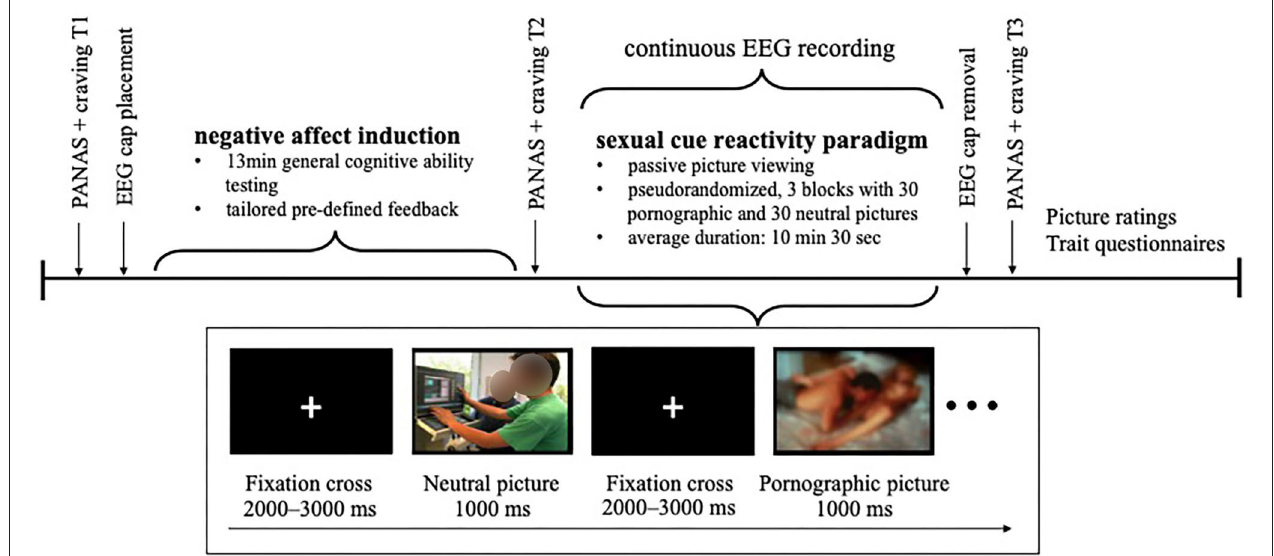
FIGURE 1 | Depiction of the experimental